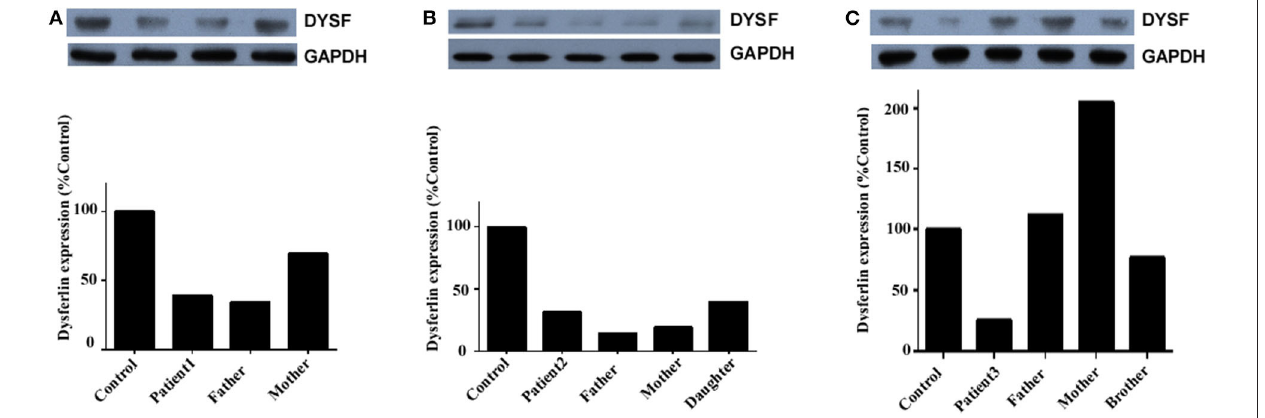
FIGURE 5 | Dysferlin expression in total PBMC of three unrelated families. (A) Relative dysferlin expression (upper panel) in patient 1’s family. The father was also a patient (patient 1-F), and the mother was a carrier. (B) Relative dysferlin expression (upper panel) in patient 2’s family. The father, mother, and daughter were carriers. (C) Relative dysferlin expression (upper panel) in patient 3’s family. The father, mother, and brother were carriers. GAPDH (lower panel) was used as a loading control. The data are also graphically presented. The control PBMC sample was taken from patient 1’s sister with informed consent since she is a non-carrier of DYSF